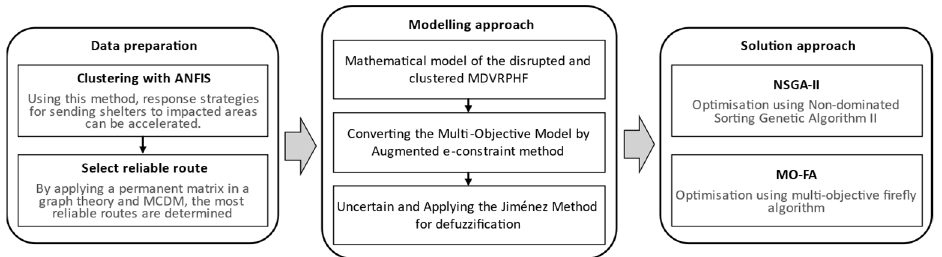
Figure 1. The research strategy by visual narrative.